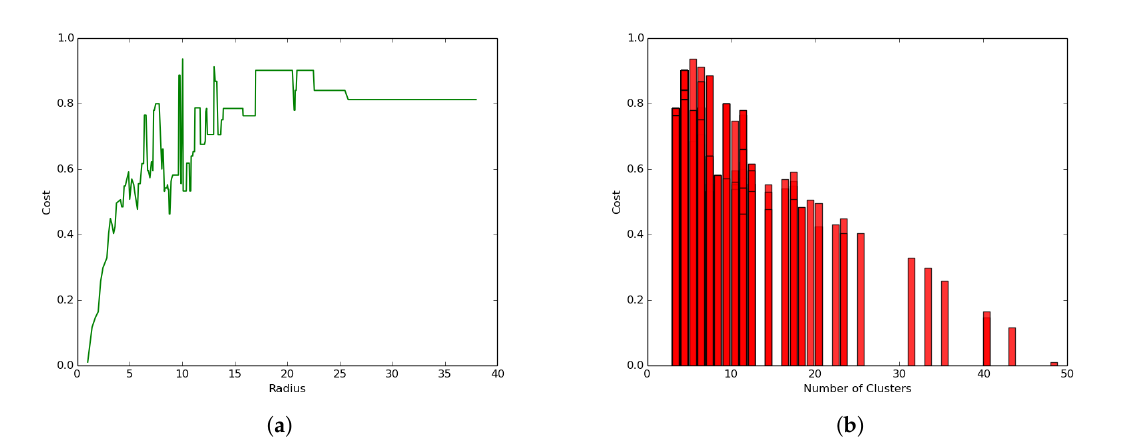
Figure 12. Impact of UAV on clustering. ( a ) Radius-cost; ( b ) communication